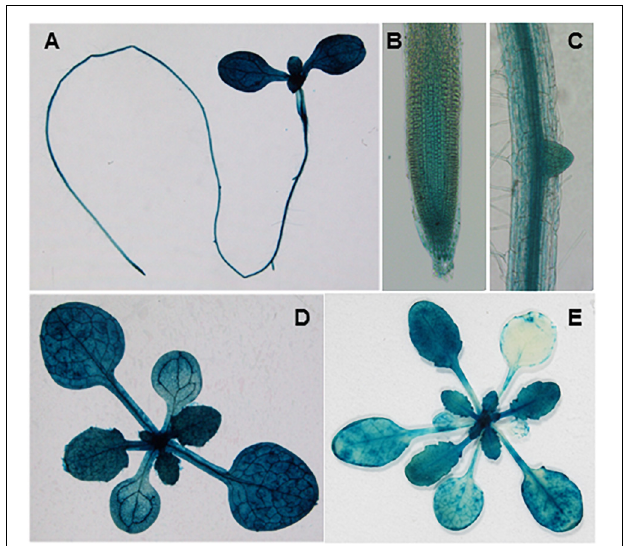
FIGURE 5 | Tissue expression patterns of SVR11 . GUS staining of transgenic plants expressing the SVR11 promoter-GUS fusion vector pSVR11::uidA . The GUS staining was performed with three independent transgenic lines. Representative whole seedling (A) , root tip (B) , and lateral root (C) of 6-day-old transgenic seedling grown on half-strength Murashige and Skoog (MS) solid medium containing 1% sucrose. Representative leaf tissues above the soil from 2-week-old (D) and 3-week-old (E)